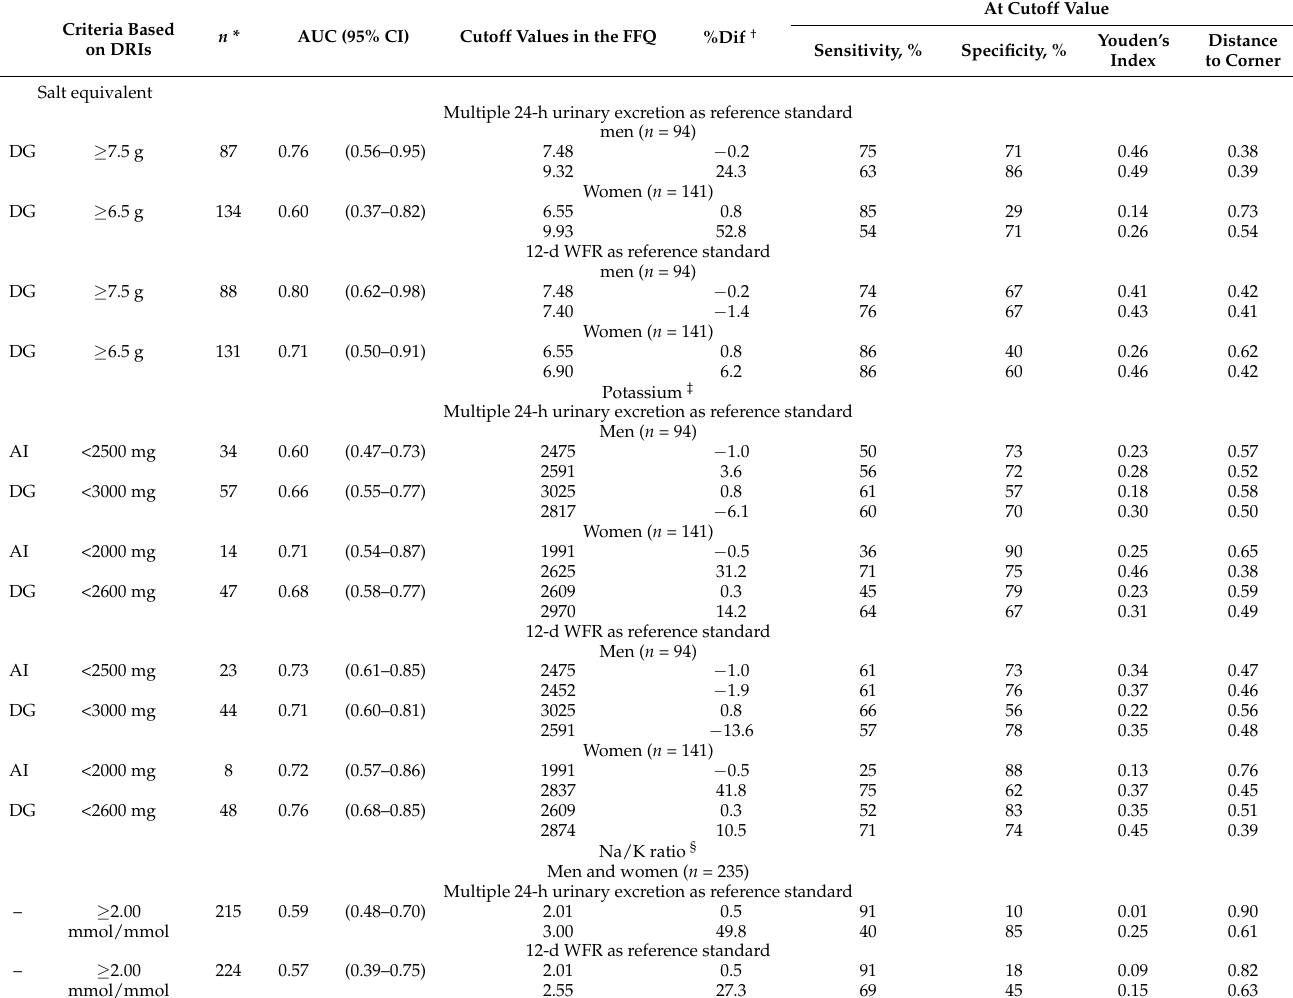
Table 3. Accuracy of the estimated salt and potassium intake levels using the FFQ to detect individuals with intake levels that deviated from the DRIs measured using multiple 24-h urinary excretion measurements or the 12-day WFR